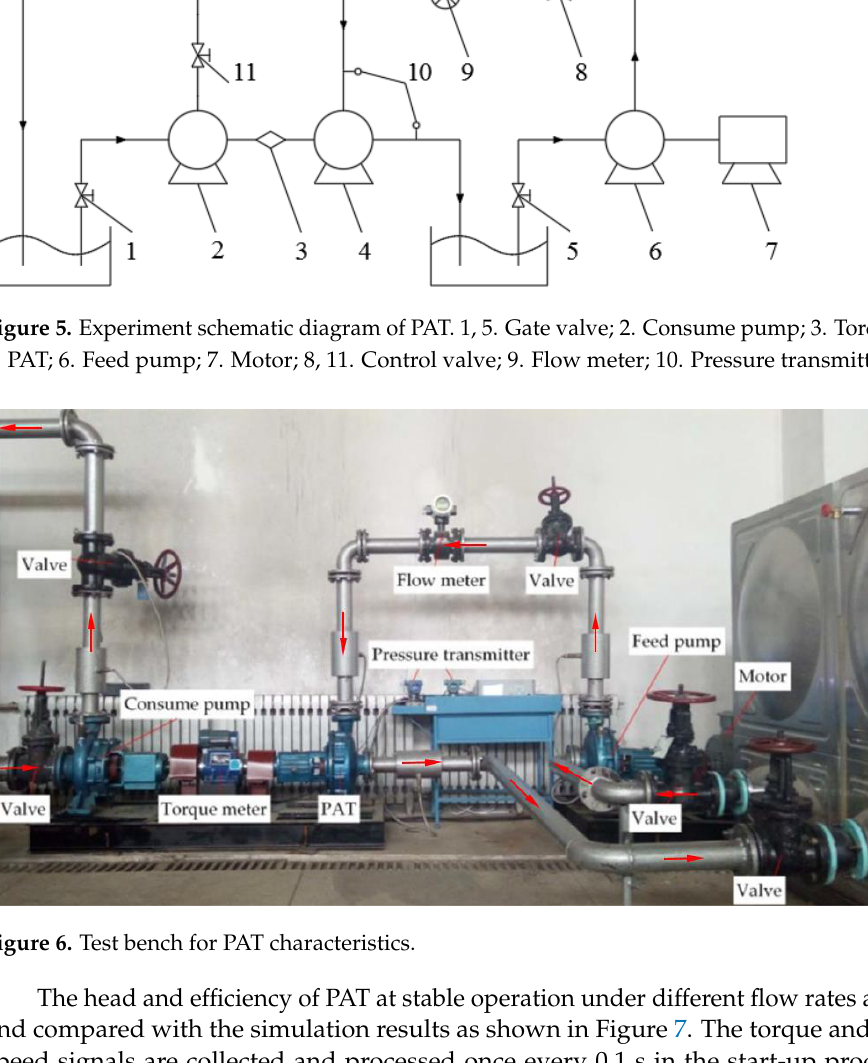
Figure 6. Test bench for PAT characteristics.